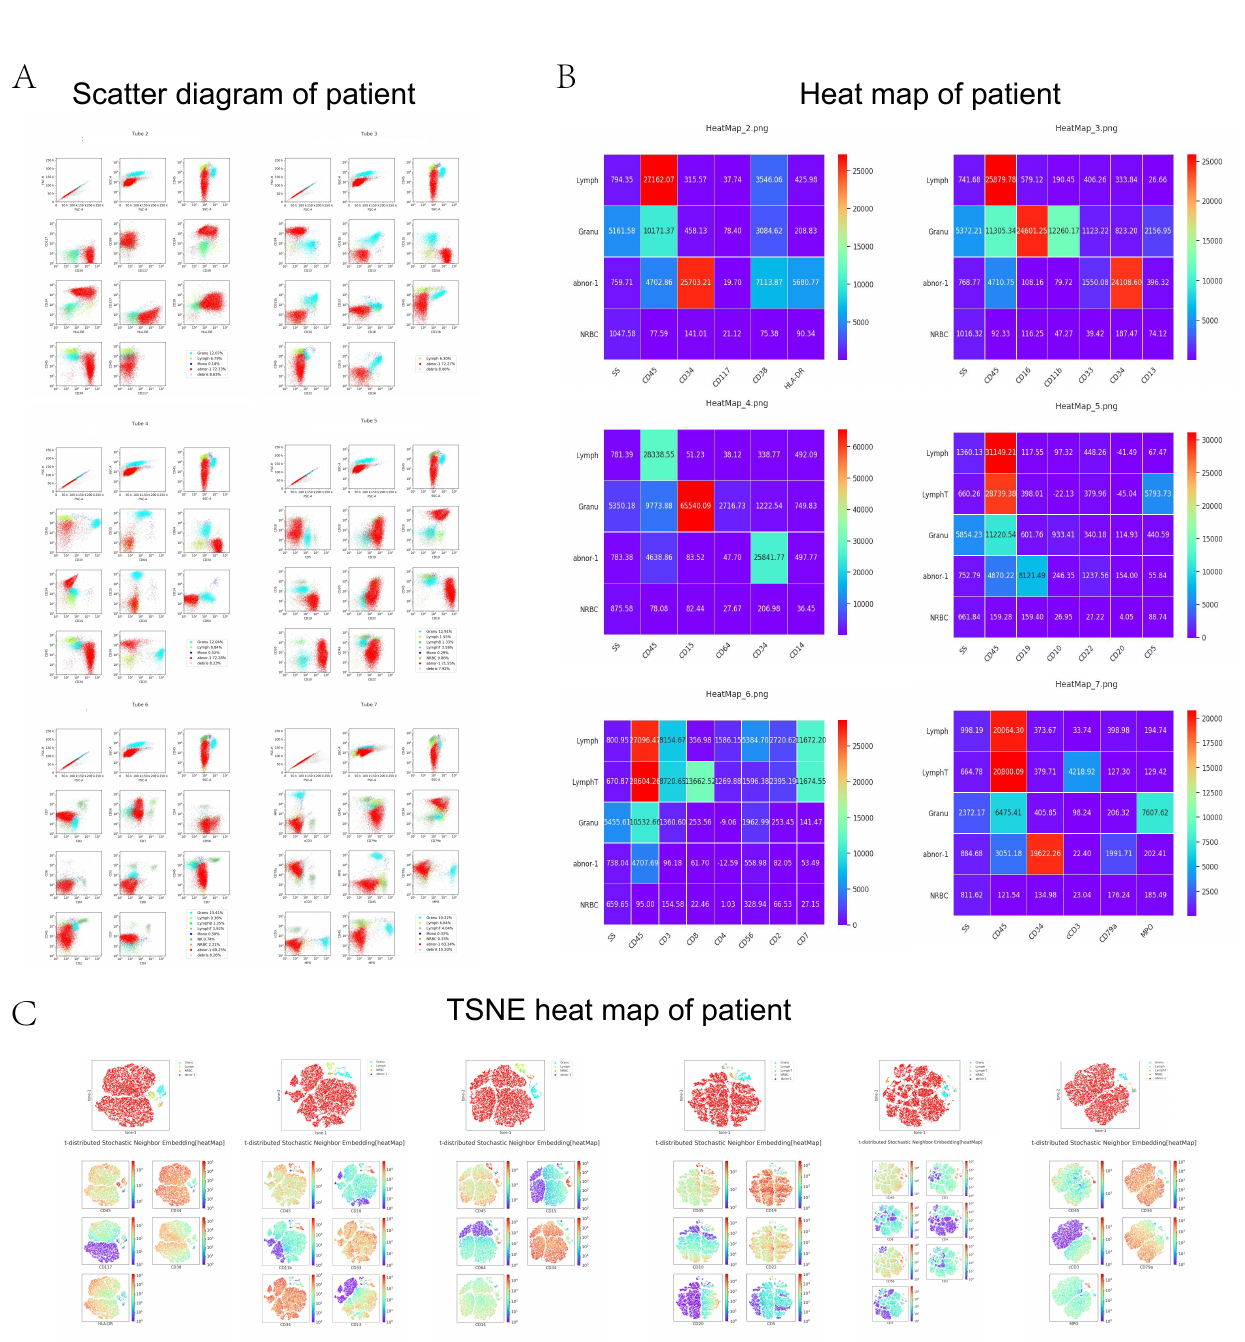
Figure 3. The representative scatter diagram, heat map, and TSNE plot of the patient. ( A ) Scatter diagram; ( B ) heat map; and ( C ) TSNE heat